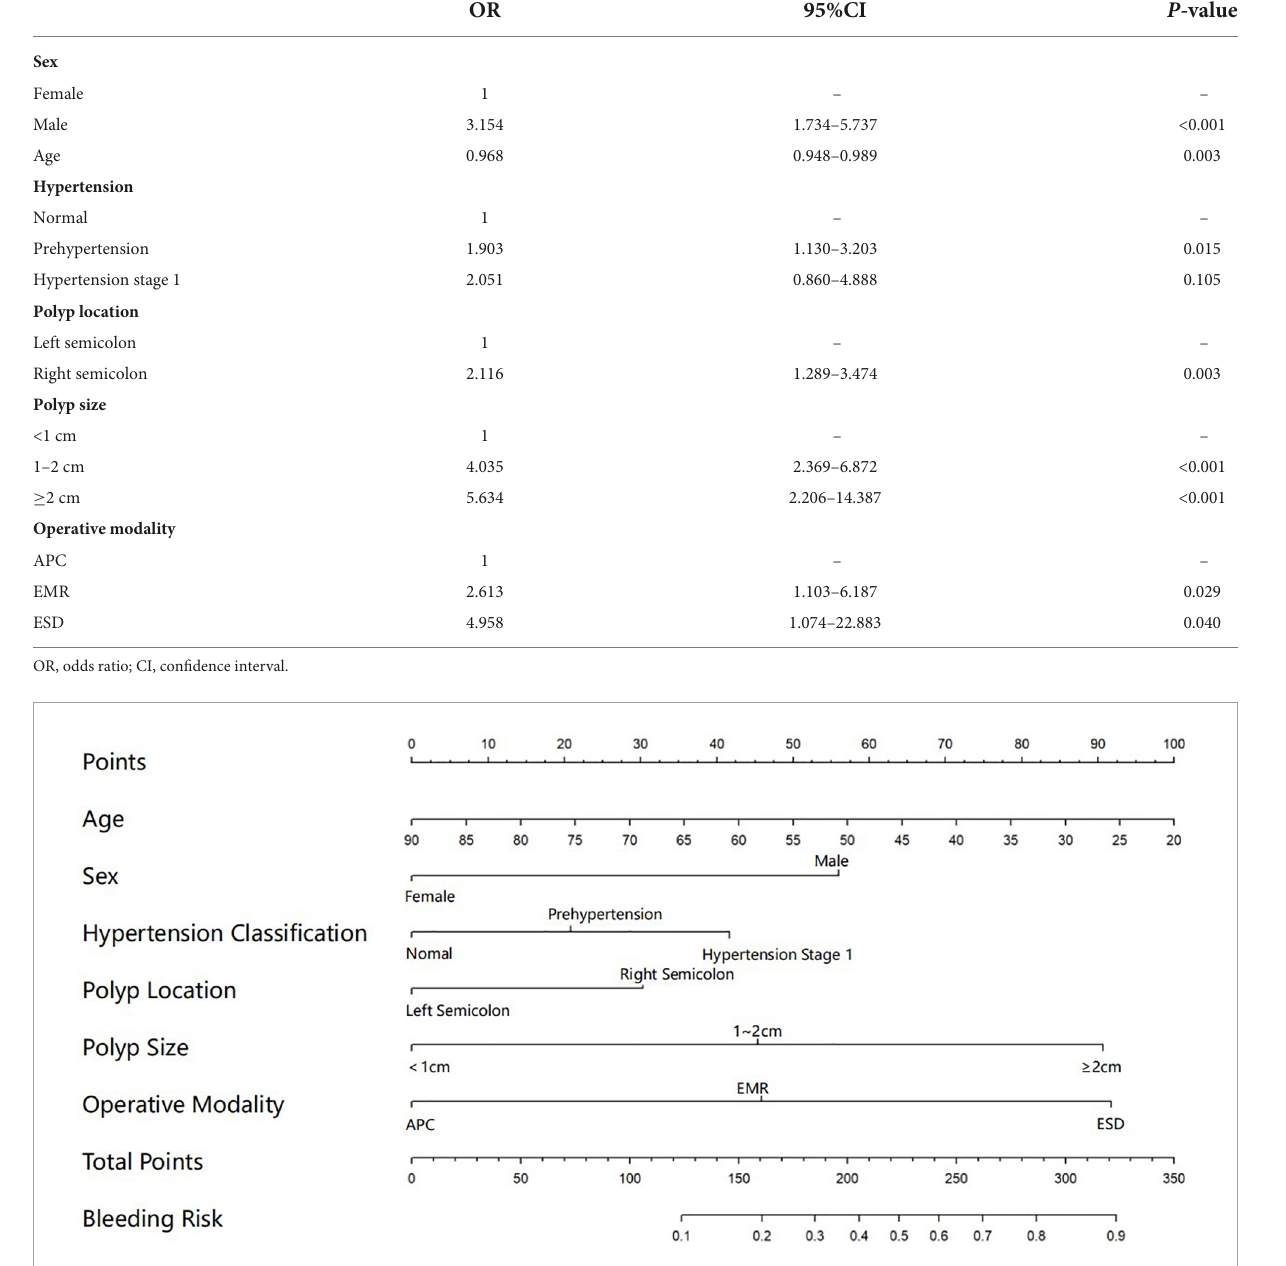
FIGURE3 Nomogram for predicting delayed post-polypectomy bleeding (DPPB) in patients who receive colonoscopic polypectomy. Each variable has matched points assigned to a given magnitude of the variable, after calculating the total score, a risk score of DPPB can be found.